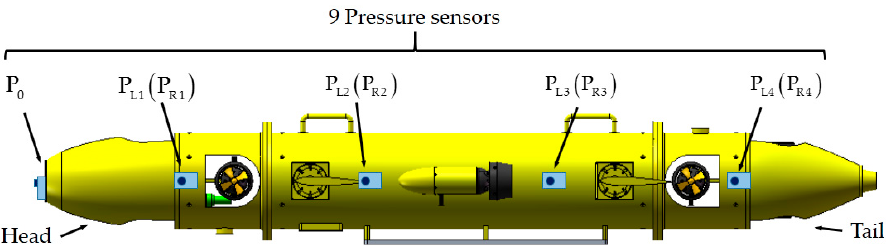
Figure 4. The position of pressure sensors. The nine pressure sensors are labeled as P 0 , P L 1 , P L 2 , P L 3 , P L 4 , P R 1 , P R 2 , P R 3 and P R 4 .